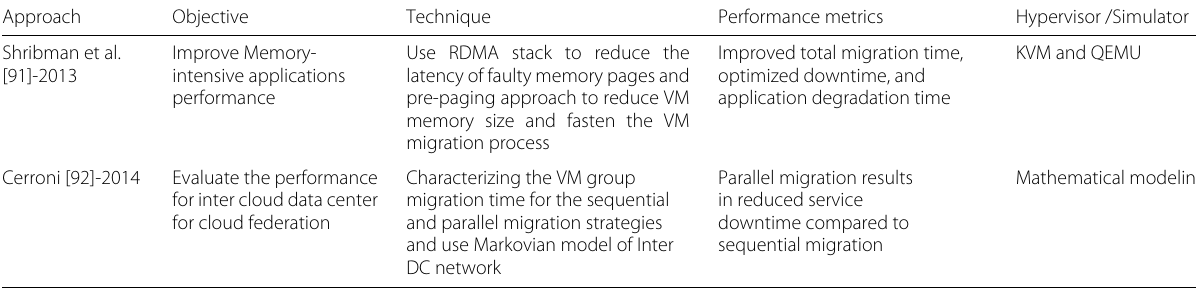
Table 5 Comparison of Single & Multiple VM migration approaches